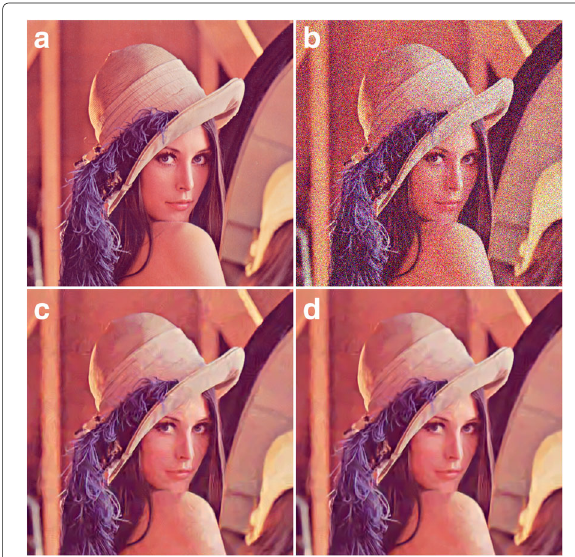
Fig. 8 Subjective assessment between the DC-only profile of BM3D and the proposed method. a Original image. b Noisy image at noise level σ = 20, PSNR = 22.13, and SSIM = 0.3402. c Output using the DC-only of BM3D, PSNR = 28.21 and SSIM = 0.7883. d Proposed Method’s Output, PSNR = 29.65 and SSIM =